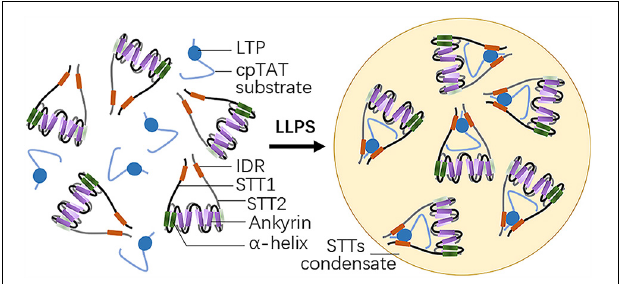
FIGURE 1 | Structure of STT1/2 and LLPS driven by STT1/2. Both STT1 and STT2 have an N-terminal intrinsically disordered region (IDR) and five C-terminal ankyrin repeat domains following two α -helixes. STT1 and STT2 form an ellipsoidal-like core structure via the antiparallel interaction of their five ankyrin repeat domains and two adjacent N-terminal helixes. STT1 and STT2 complex binds the lumen targeting peptide (LTP) of the cpTat substrate by their IDRs and undergo liquid-liquid phase separation